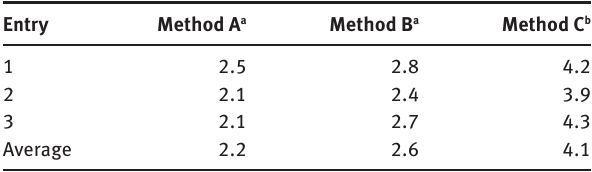
Table 2: Yields (%) of naringin extraction by different methods.